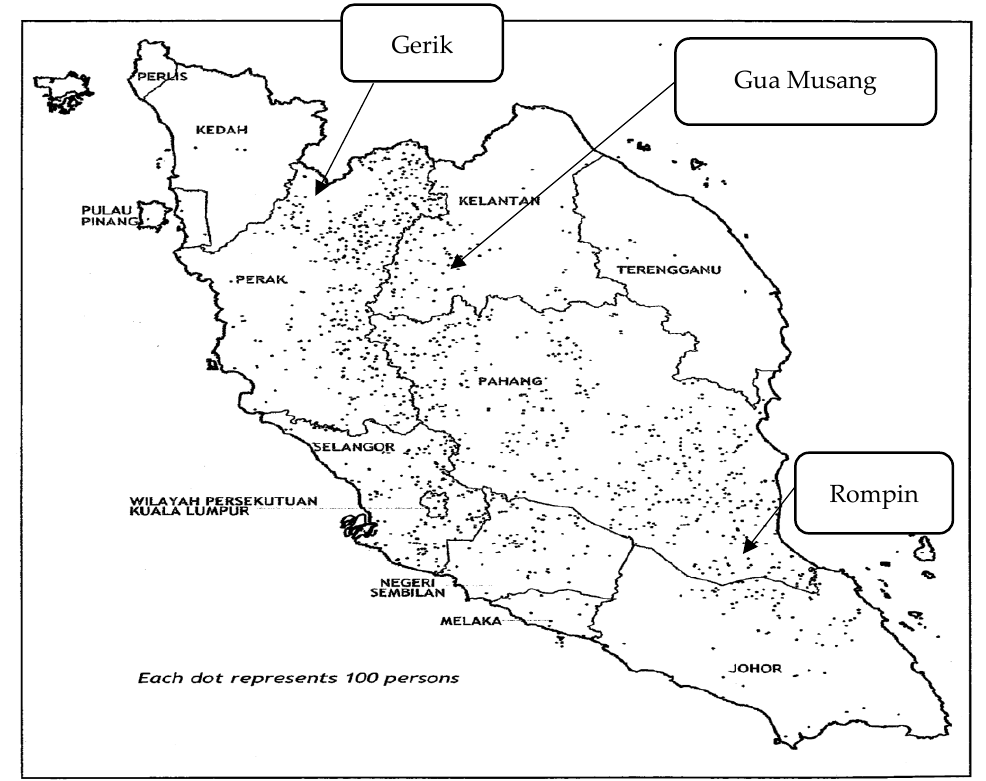
Figure 1. Distribution of Orang Asli in Peninsular Malaysia, 2000.